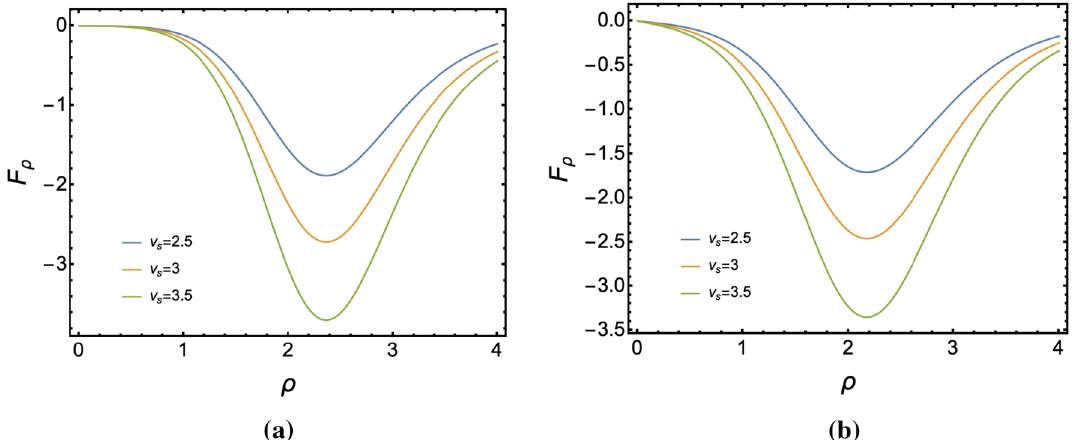
Fig. 4 The ρ component of the distortion force with a ¯ x = 0, b ¯ x = 1 as a function of ρ for different v s . Warp bubble parameters are R = 2, σ = 1. All numerical values are in natural